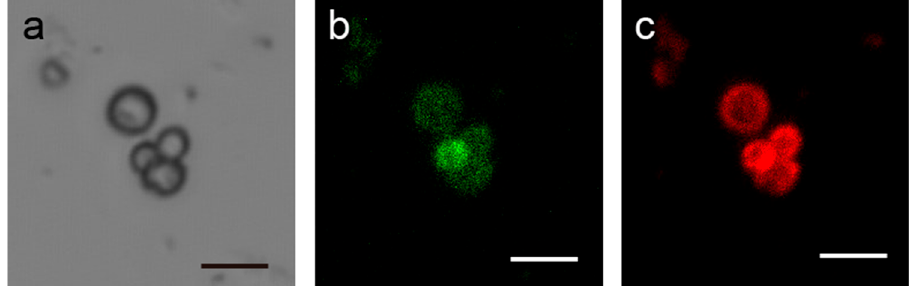
Figure 10. Optical microscopy ( a ) and fluorescence microscopy (( b ), excitation: 488 nm) and (( c ) excitation: 543 nm) images of PAH/GOx/(SA-PAH/PBA-PAH) 5 film-coated CaCO 3 microparticles in which PBA-PAH and GOx have been labeled with FITC and TRITC, respectively. The scale bar is 5 μ m.